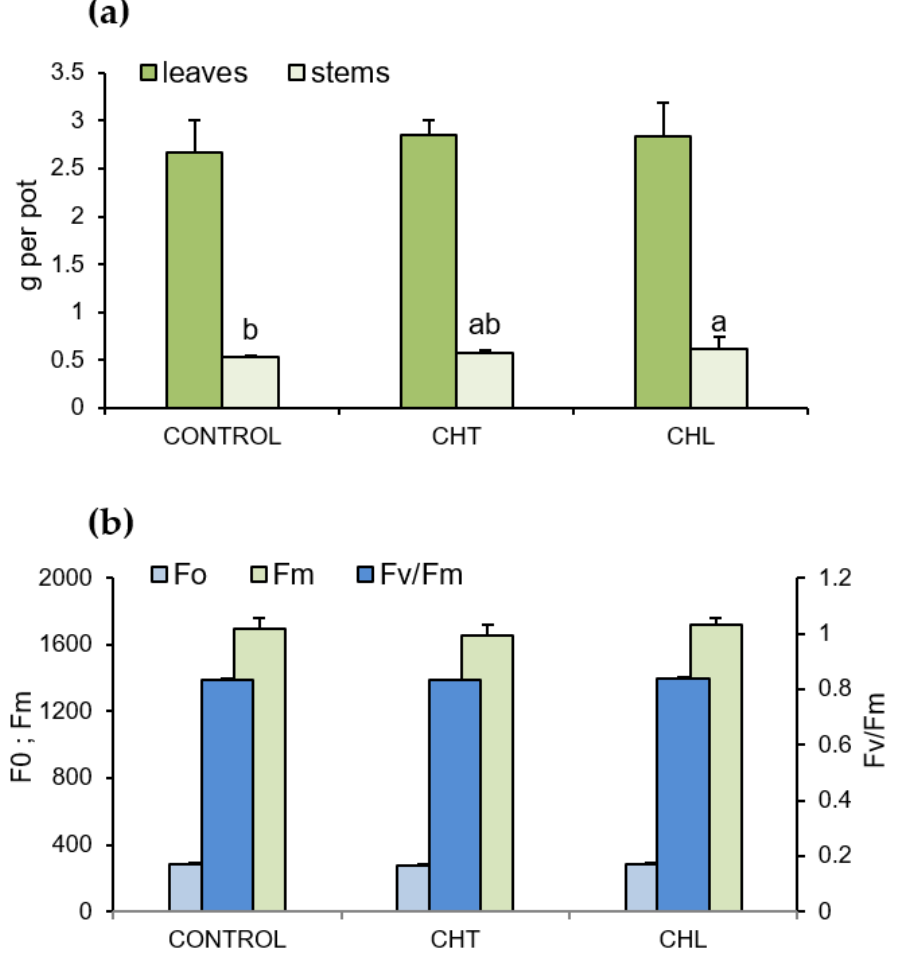
Figure 5. Dry matter yield of the aboveground parts ( a ) and selected chlorophyll a fluorescence indices ( b ) in P. amboinicus leaves, depending on the chitosan form in the solution used for spraying the plants (CHT—chitosan suspension; CHL—chitosan lactate). Mean values ( ± standard deviation; n (A) = 3, n (B) = 10) marked with different letters were statistically significantly different ( p < 0.05). The absence of letter designation means the absence of statistically significant differences.